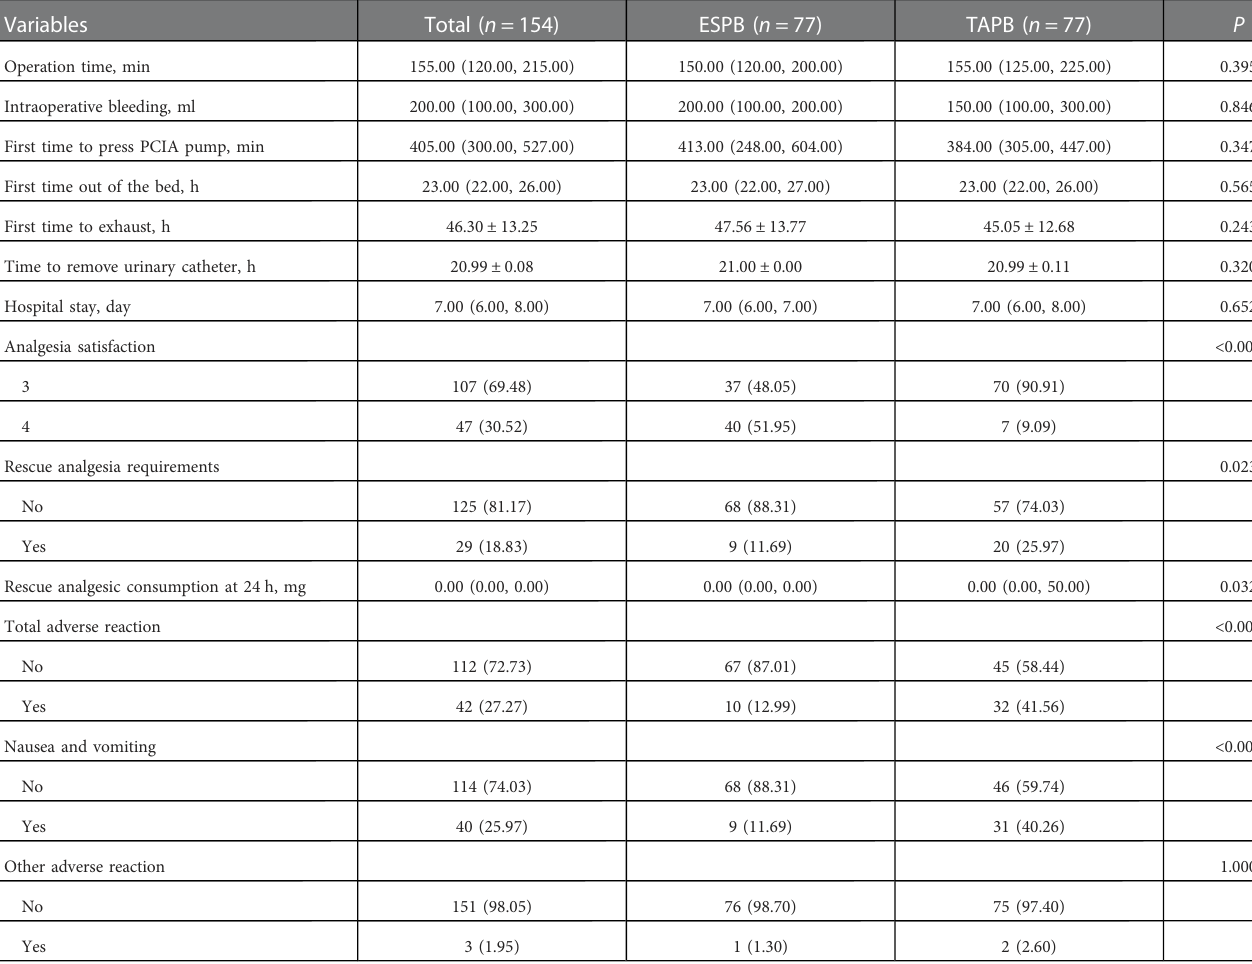
ESPB, erector spinae plane block; TAPB, transversus abdominis plane block; PCIA, patient-controlled intravenous analgesia. total adverse reaction includes nausea, vomiting, cough, and fever. Other adverse reaction means cough and fever. The measurementdata in normal distribution were described as mean±SD, and compared using independent sample t -test. The measurement data in non-normal distribution were described as M (Q1, Q3), and compared using rank-sum test. The counting data were described as n (%), and compared using χ 2 test. The ranking datawas shown as n (%), and compared using rank-sum